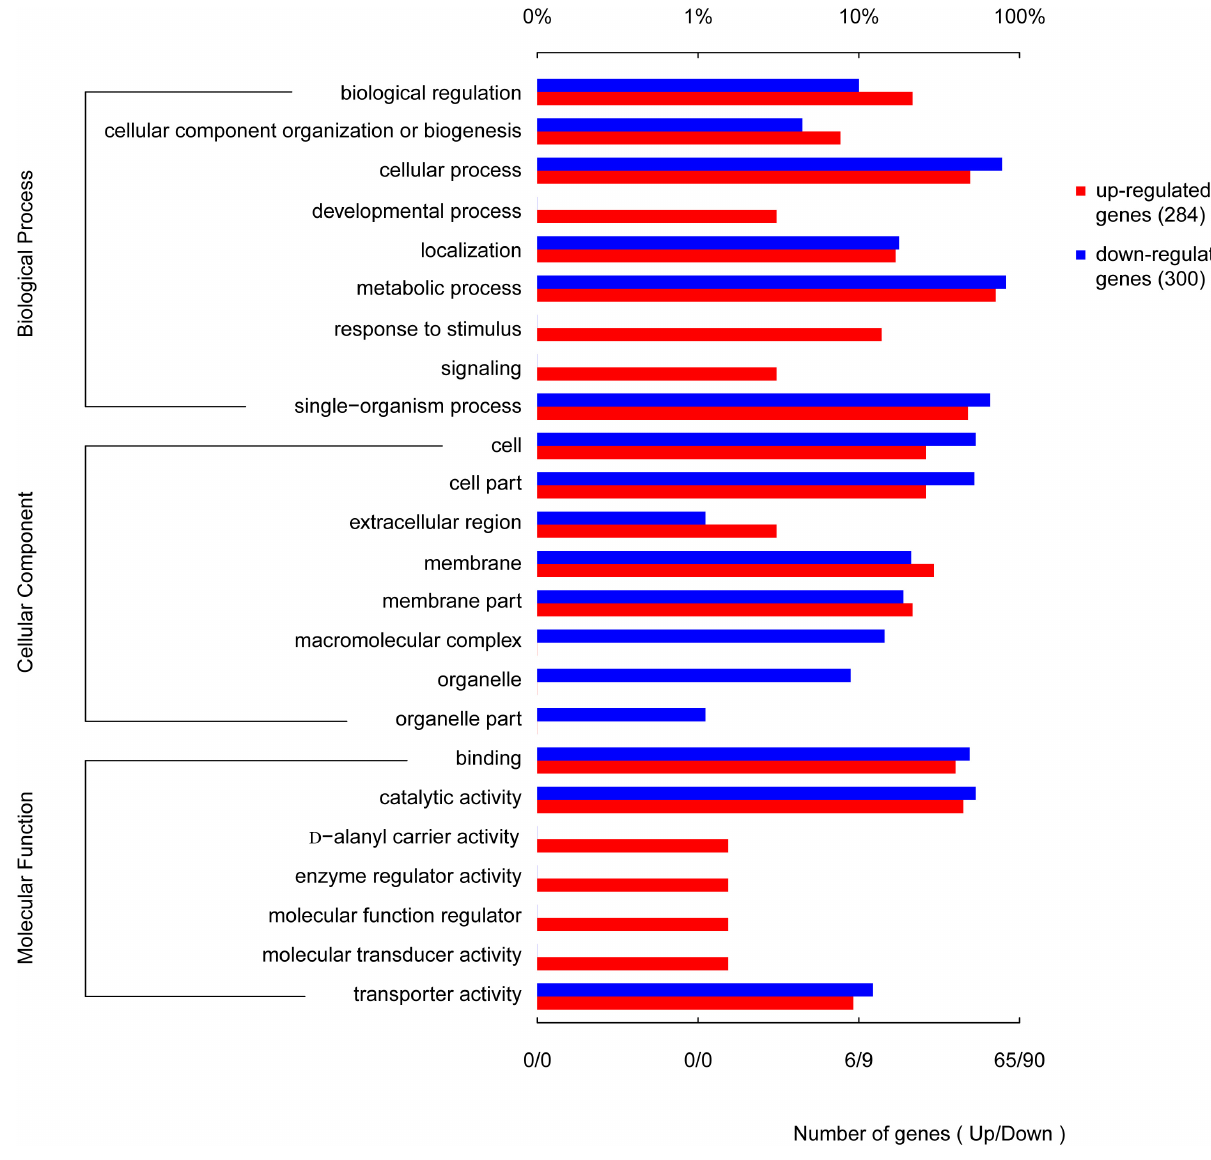
FIGURE 8 | Functional categories of the differentially expressed genes (DEGs), broadly separated into biological processes, cellular components, and molecular function based on Gene Ontology (GO) enrichment analysis. The lower abscissa indicates the number of genes annotated to a certain GO term, while the upper abscissa indicates the percentage of genes annotated to a certain GO term amongst the total number of annotated